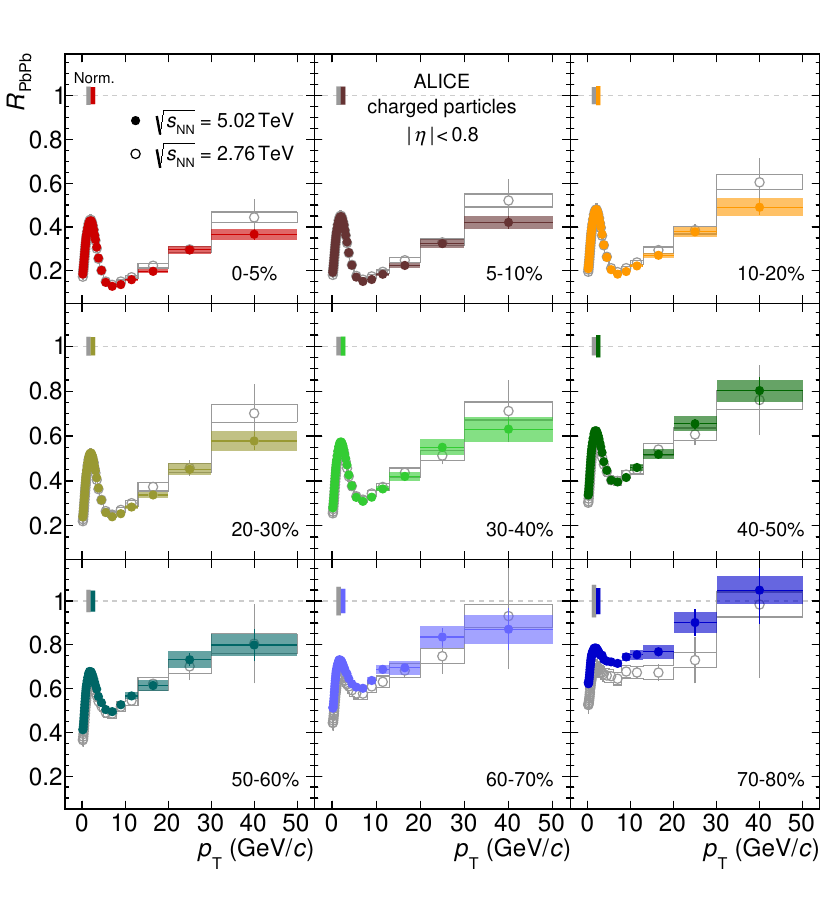
Figure 1. Nuclear modification factors, R AA for inclusive charged particles in Pb-Pb collisions at √ s NN = 2 . 76 and 5 . 02 TeV in di ff erent centrality intervals